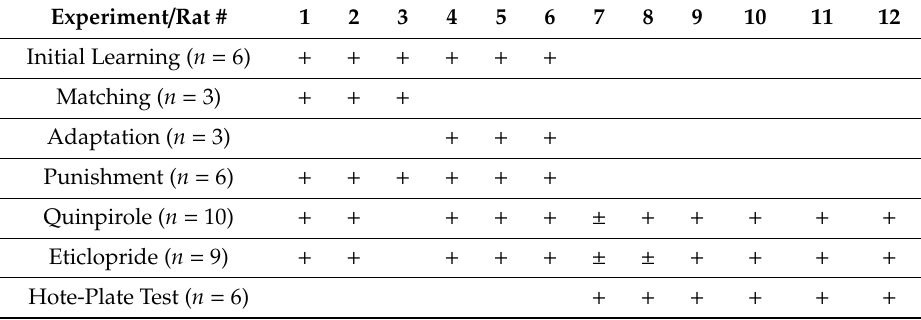
Table 3. Assignment of rats to experiments. ( + ) the animal participated in the experiment, ( ± ), the animal participated, but data were excluded from the